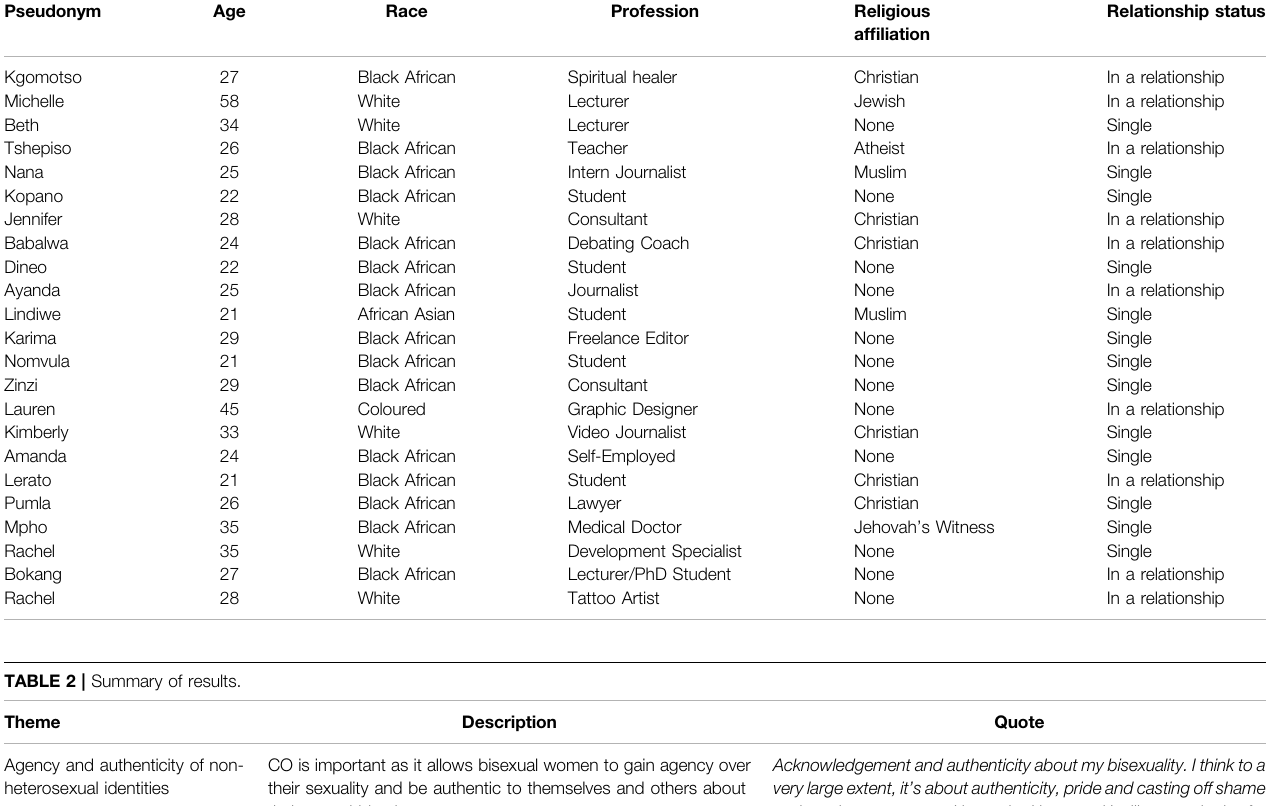
TABLE 1 | Sociodemographics of participants.